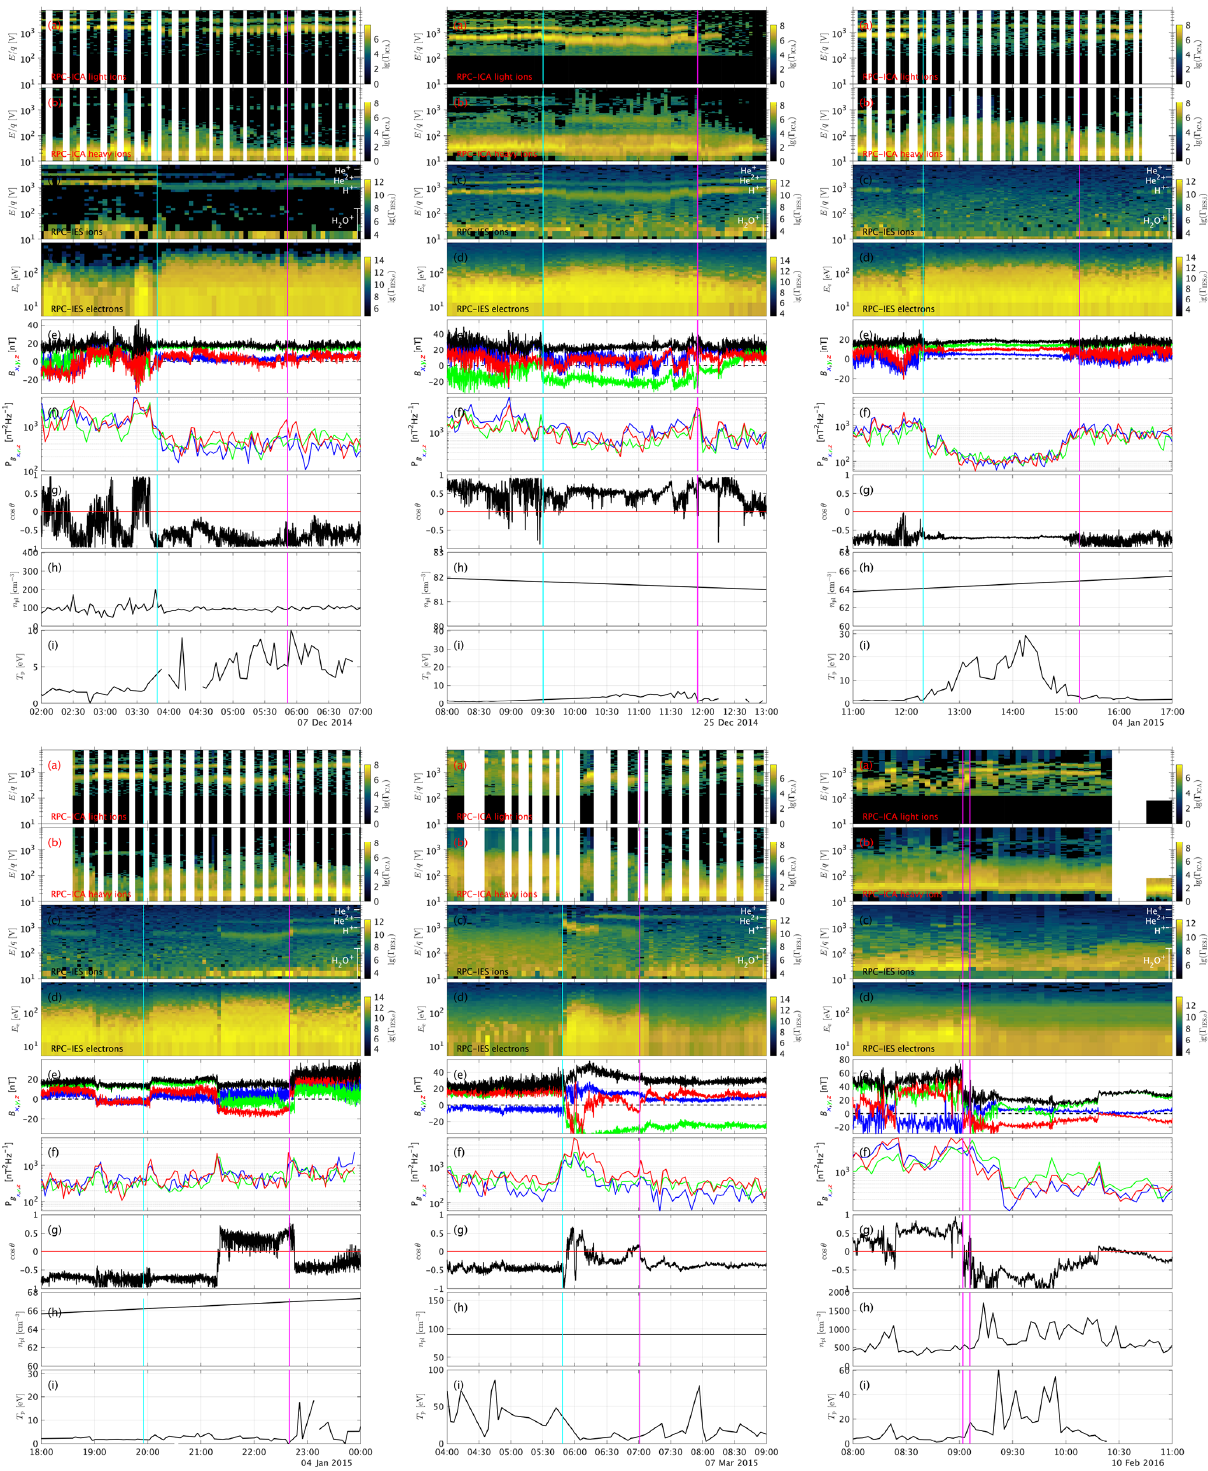
Figure A1. Observations of the plasma for the events shown in Table 1. The format is the same as in Fig. 1.